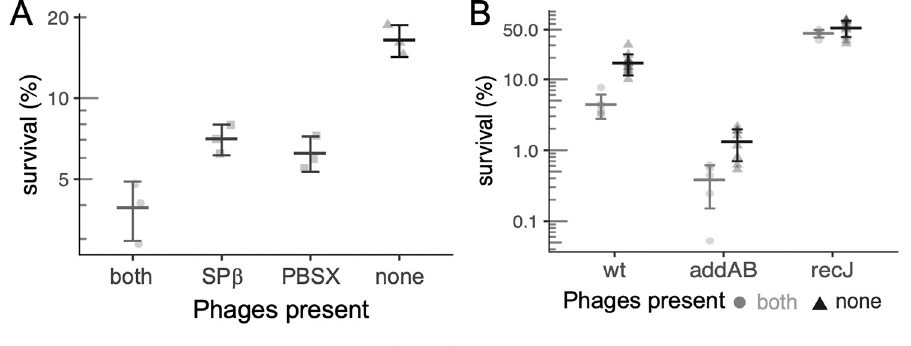
Fig 3. Effect of the resident lysogenic phages SPß and PBSX on survival after replication arrest. A. The lysogenic phages SPß and PBSX (defective) negatively affect cell survival after replication arrest (3 h HPUra treatment). Percent survival of strains JMA222 (which has both phages), LSF204 (only SPß; Δ PBSX), LSF203 (only PBSX; Δ SPß), and LSF225 (no phage; Δ PBSX, Δ SPß). B. recJ and addAB affect survival following replication arrest, even in cells without SPß and PBSX. Survival after 3 h of replication arrest for strains lacking both phage is plotted as dark gray triangles with black error bars; wt (LSF225), Δ addAB (LSF254), and Δ recJ (LSF231). Data from corresponding strains with both phages (JMA222, LSF253, and LSF200, respectively), plotted as light gray circles with gray error bars, are shown for comparison, and are the same as presented in Fig 1B. Statistically different means, by two-tailed t-test: � P < 0.05; �� P < 0.001; ��� P <